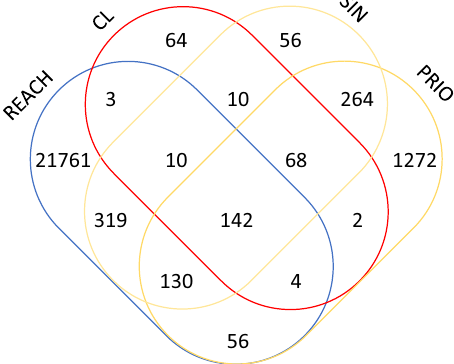
Fig. 4 | Overlap of substances among the chemical lists. Venn diagram repre- sentingtheoverlappingofchemicalsubstancesincludedintheEuropeanchemical regulation Registration, Evaluation, Authorization, and Restriction of Chemicals (REACH, n =22,425), Candidate List (CL, n =303), SIN List (SIN, n =999), and PRIO List (PRIO, n